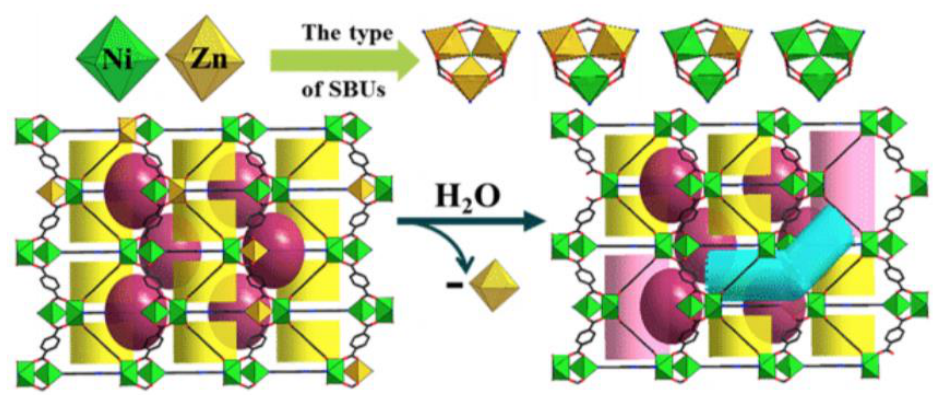
Figure 7. Generation of hierarchical porous framework via selective SBU hydrolysis in [M 3 F(bdc) 3 tpt] [178]. Adapted from ref. 180 with